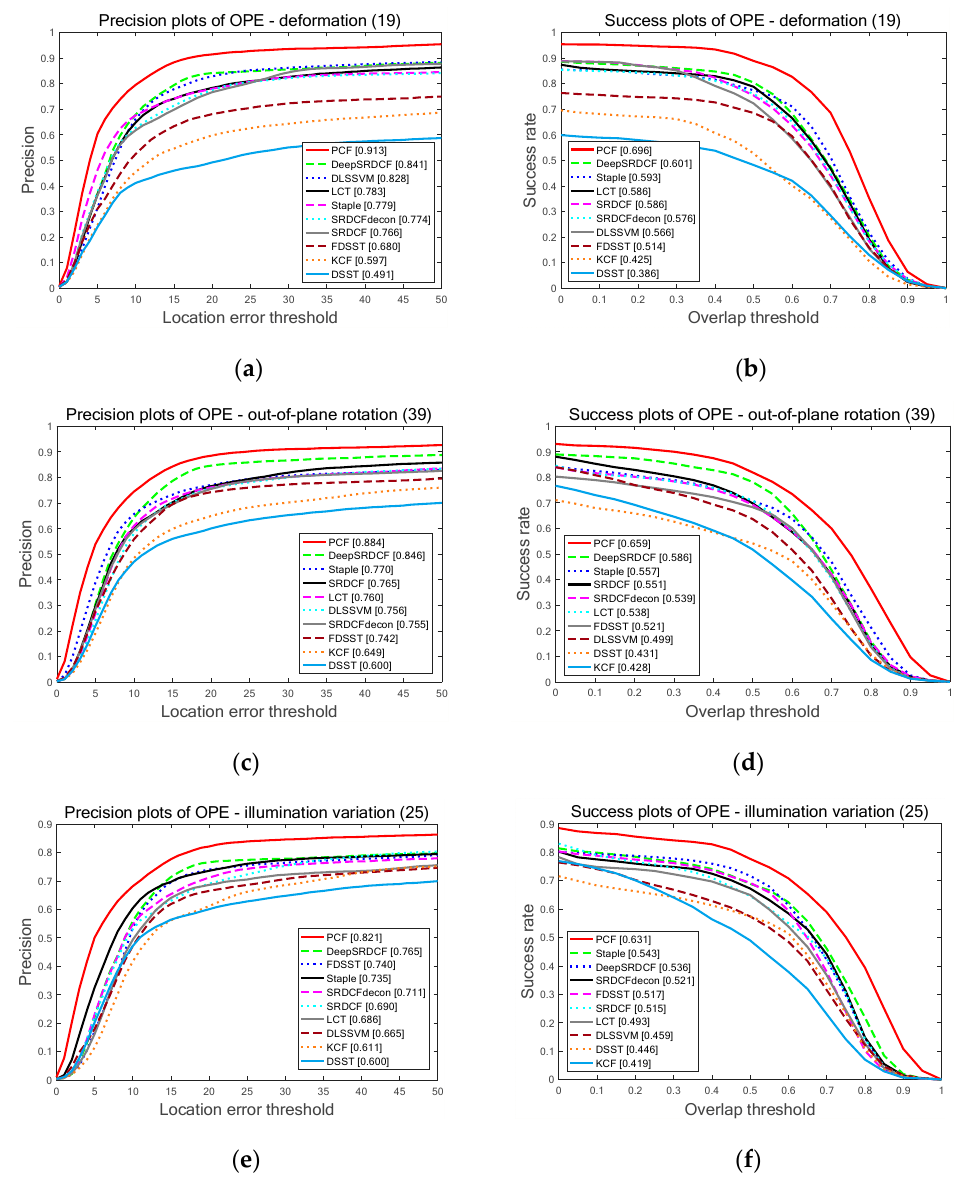
Figure 7. The quantitative results of the top ten trackers on OTB-2013 benchmark among three di ff erent contributions: DEF, OPR, and IV. Among the top ten trackers, the proposed PCF tracker obtains the best results on all three attributes: ( a ) The PP of the OPE on attribute DEF; ( b ) The SP of the OPE on attribute DEF; ( c ) The PP of the OPE on attribute OPR; ( d ) The SP of the OPE on attribute OPR; ( e ) The PP of the OPE on attribute IV; ( f ) The SP of the OPE on attribute IV.